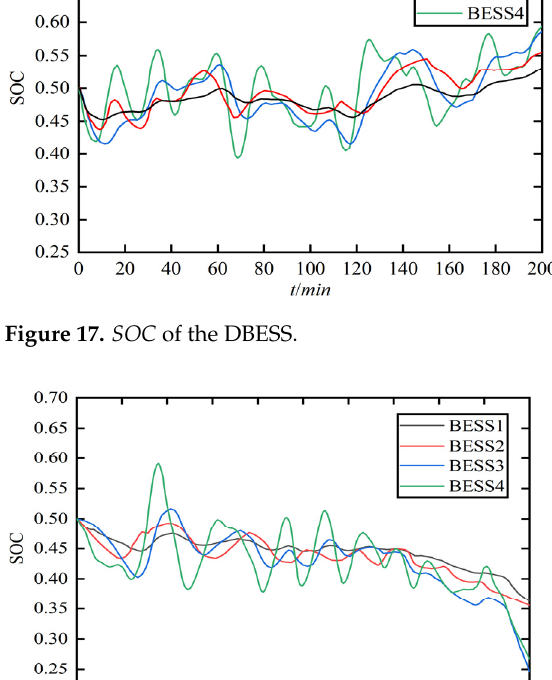
Figure 17. SOC of the DBESS.